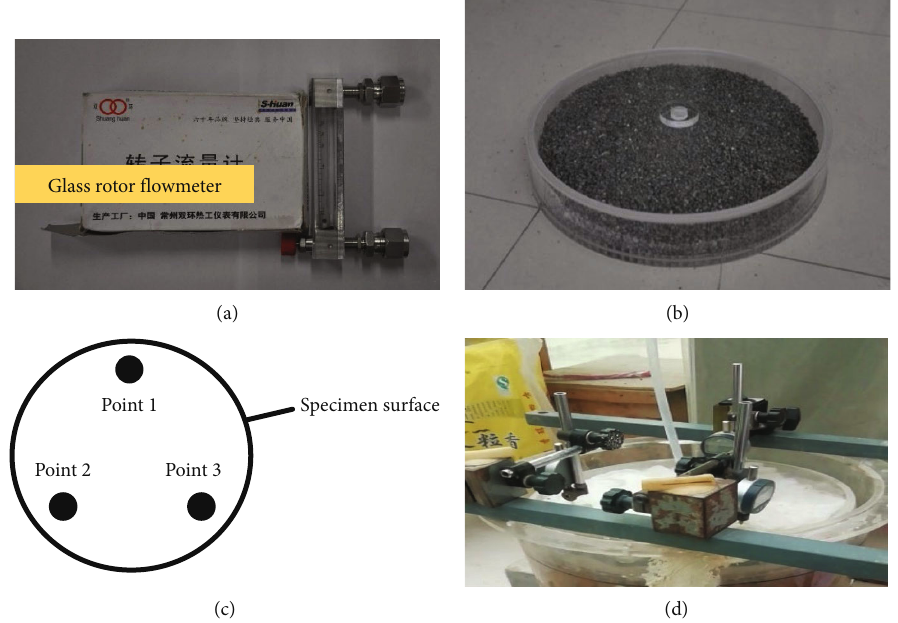
Figure 2: Components of test equipment: (a) LZB-3WBF type glass rotor fl owmeter; (b) porous water box with quartz sand; (c) sedimentation measuring point; (d) actual layout of the dial